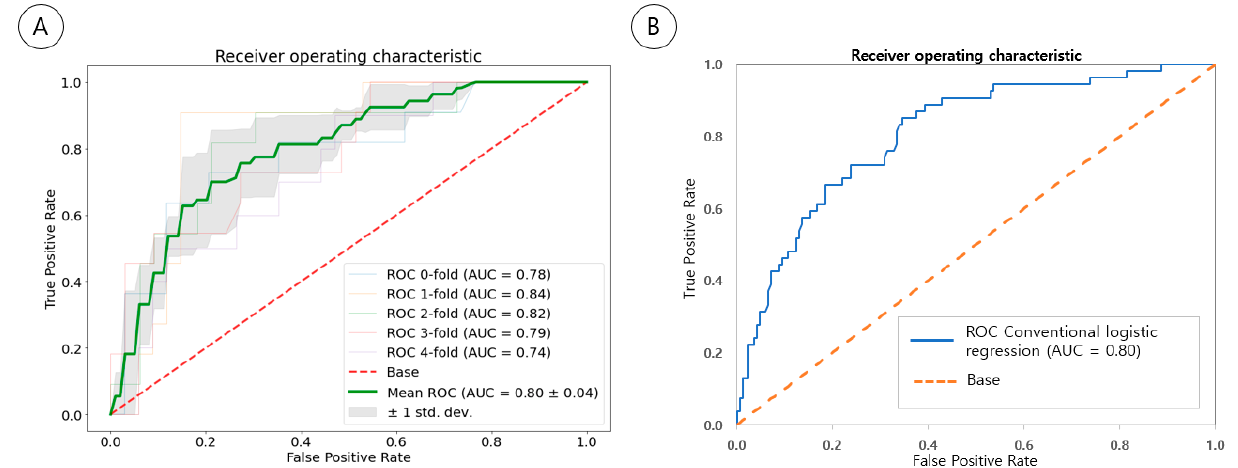
Figure 5. AUCs of the predictive model and classical logistic regression model: ( A ) K-fold cross validation (K = 5) of the XGBoost classifier (mean AUC 0.80 ± 0.04); and ( B ) AUC of the classical logistic regression model (AUC = 0.80).